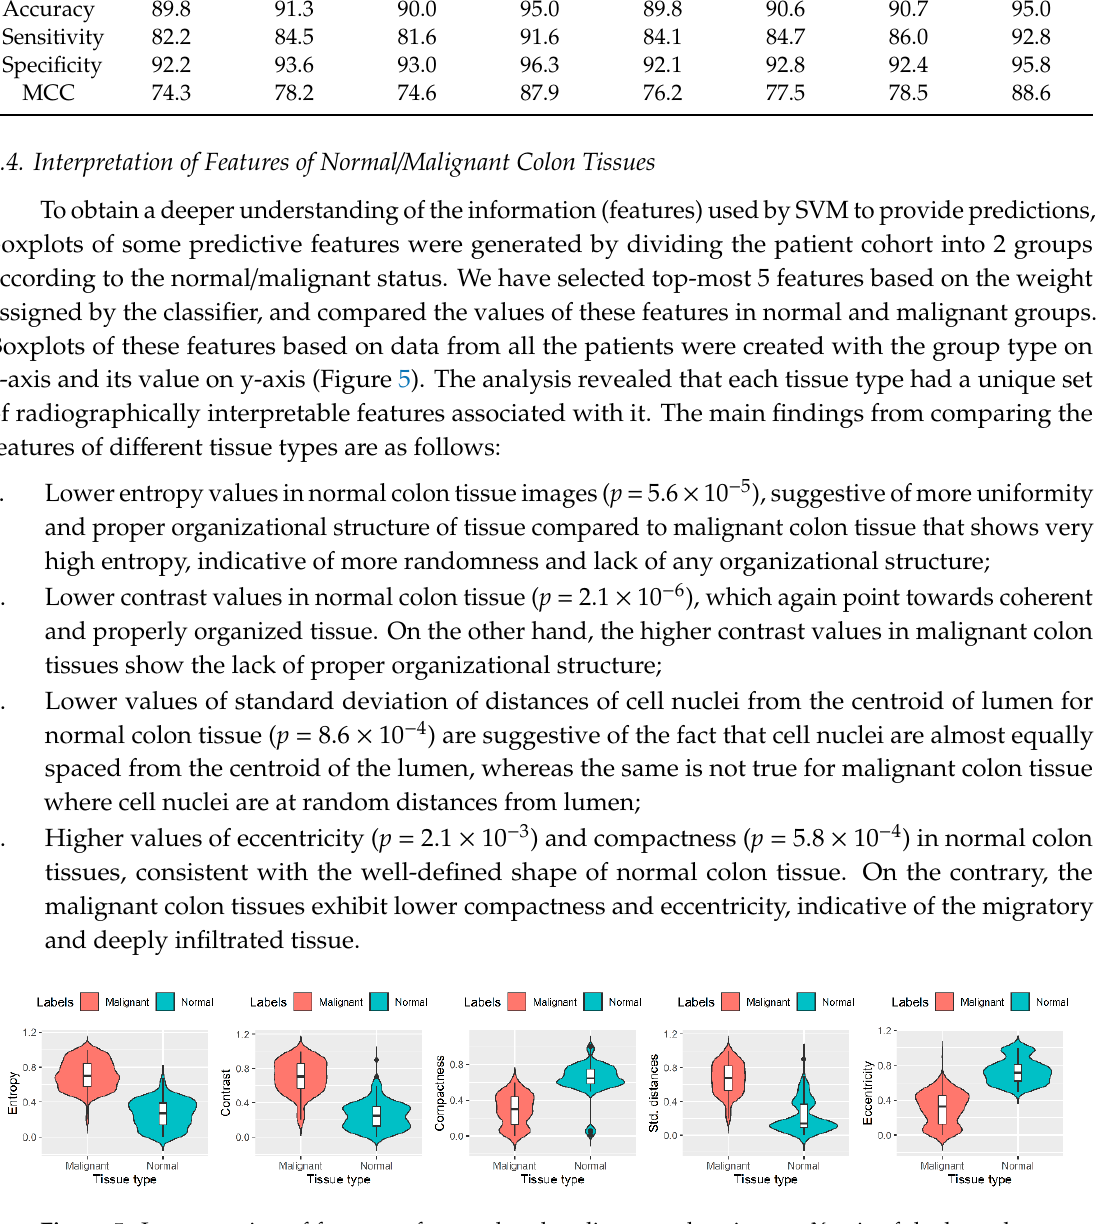
Figure 5. Interpretation of features of normal and malignant colon tissues. X-axis of the box-plots shows the tissue type, which is either normal or malignant, and the y-axis shows the value of the feature. The feature of standard deviation of distances (Std. distances) was scaled in the range (0 – 1) for better visualization.